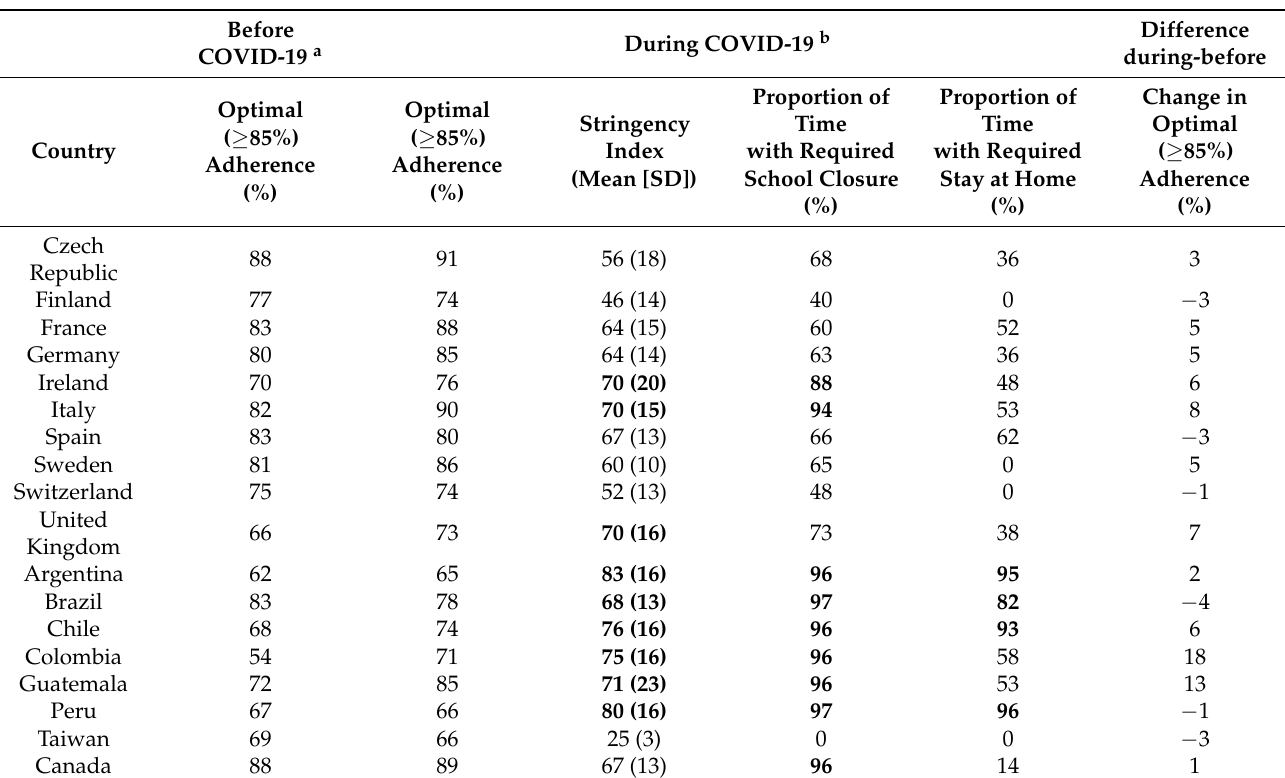
Table 2. Adherence before and during the COVID-19 period and the COVID-19 regulations, by